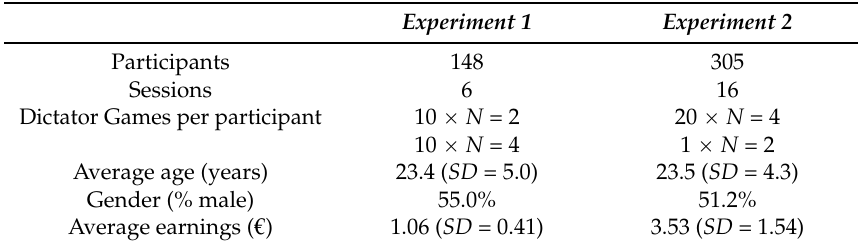
Table 2. Summary of the Multiplayer Dictator Game